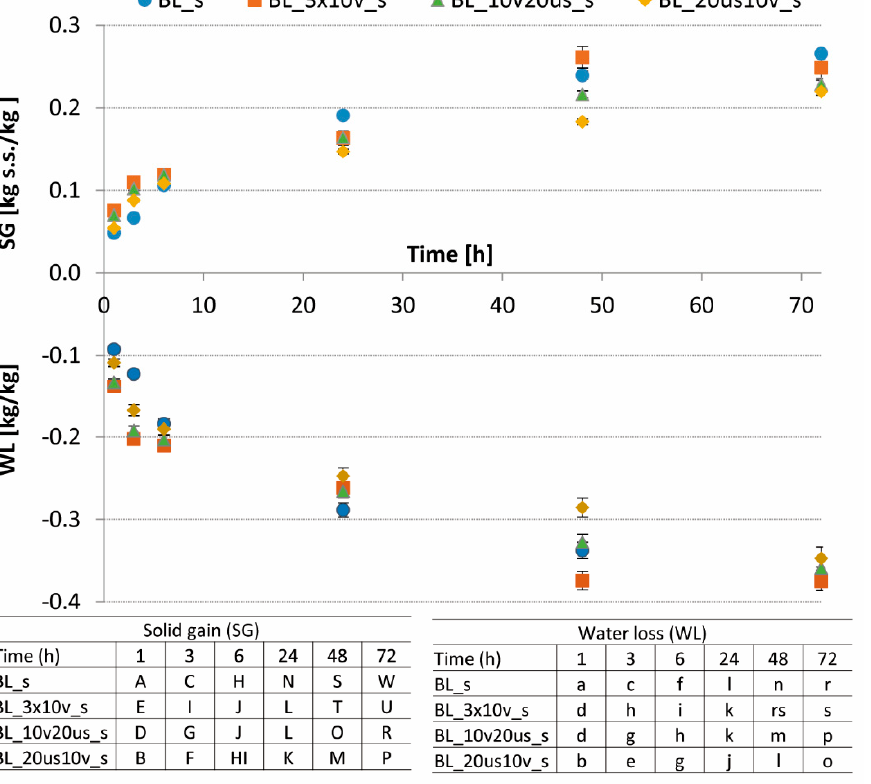
Figure 1. Water loss (WL) and solid gain (SG) as a function of the osmotic dehydration time of different treated cranberries in 61.5% sucrose solution. Different letter means significant difference by the Duncan test ( p < 0.05).